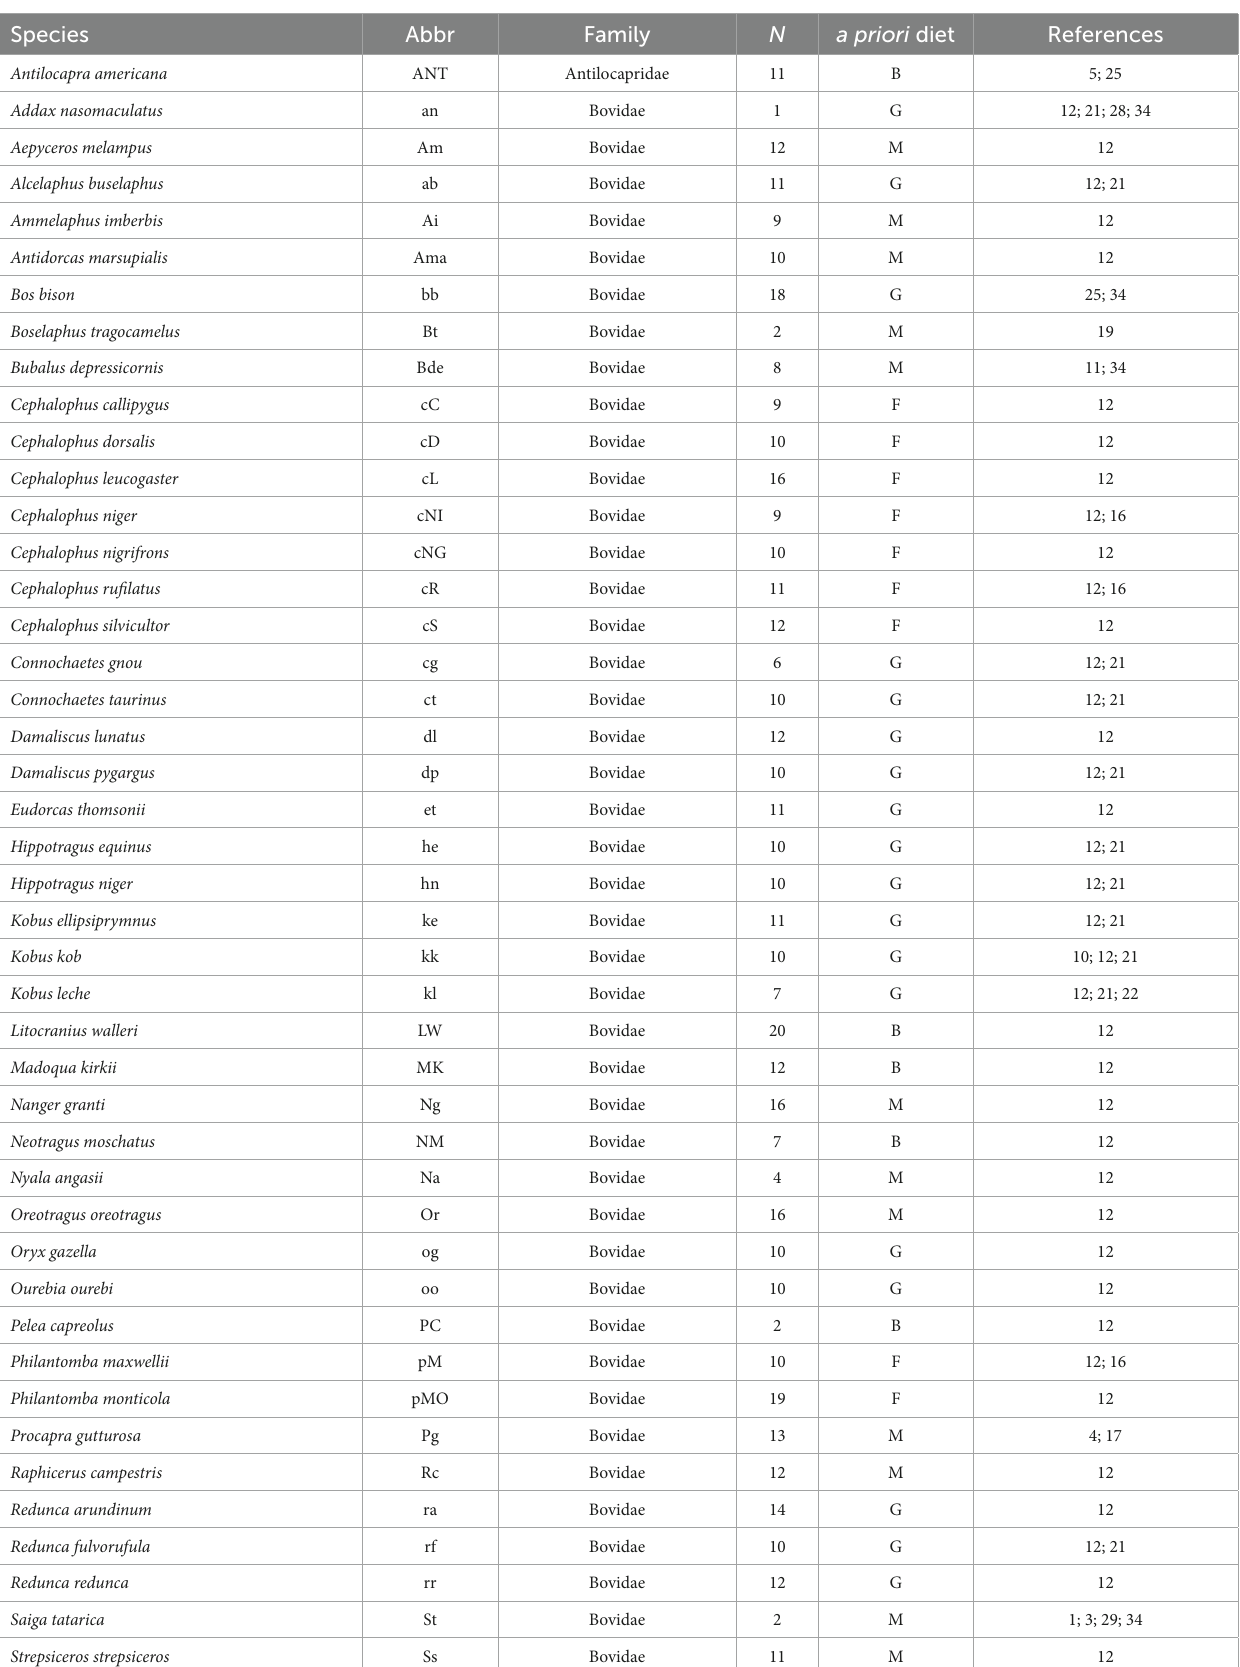
TABLE 1 Species with high-quality a priori dietary assignments derived from the literature. Species Abbr Family